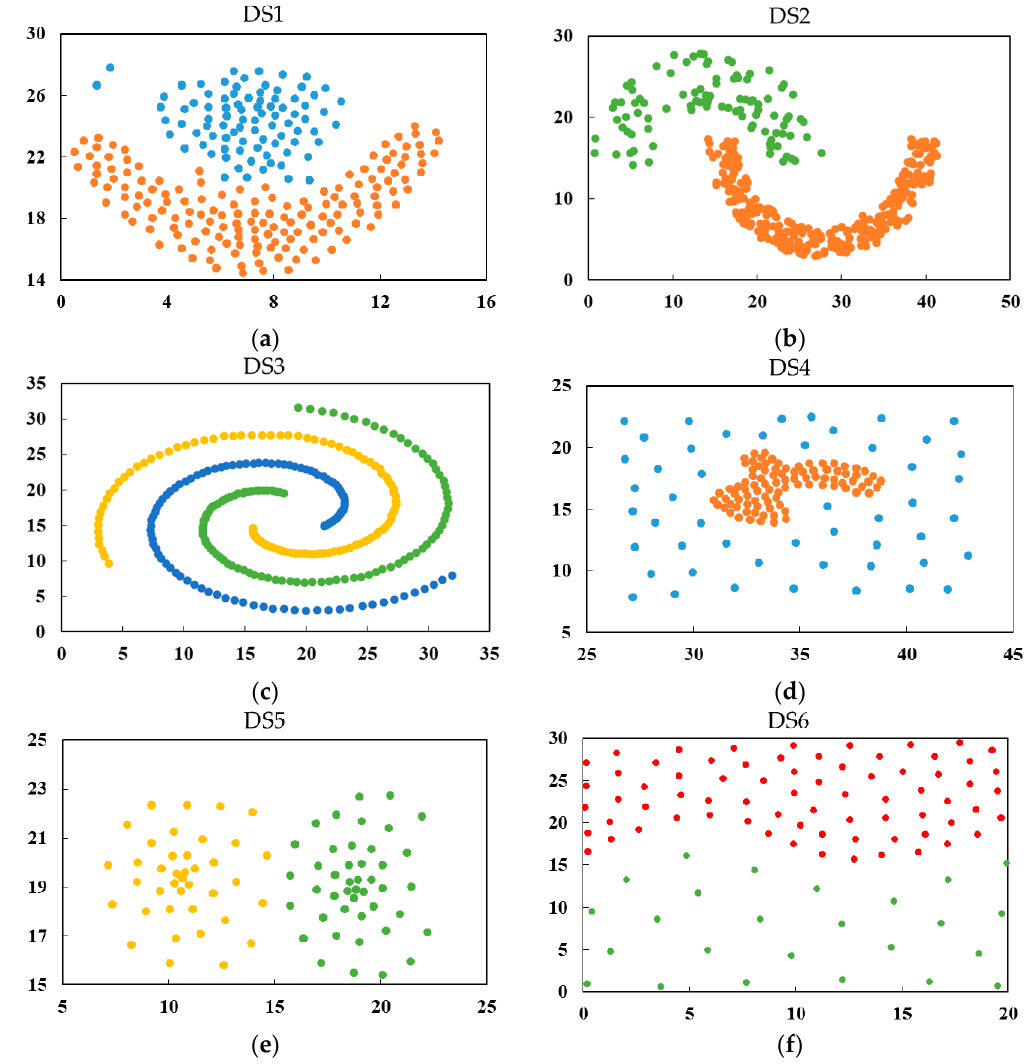
Figure 4. Illustration of the six original synthetic datasets. ( a ) Experimental data of DS1; ( b ) Experimental data of DS2; ( c ) Experimental data of DS3; ( d ) Experimental data of DS4; ( e ) Experimental data of DS5; ( f ) Experimental data of DS6.